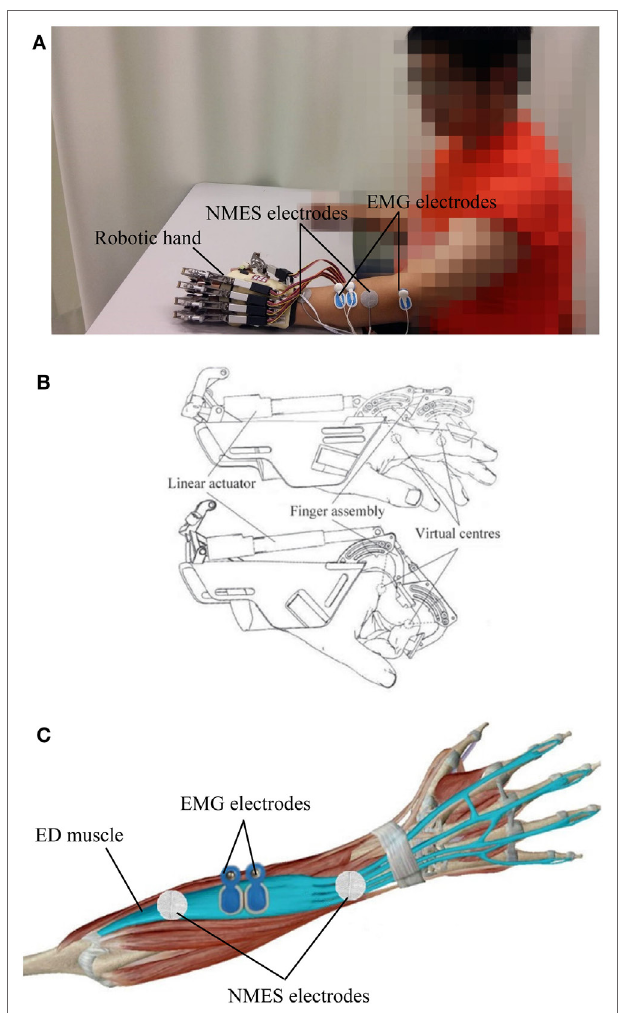
FiGUrE 1 | The electromyography (EMG)-driven neuromuscular electrical stimulation (NMES)-robotic hand system: (a) the wearable system consisting of a mechanical exoskeleton of the robotic hand, a pair of NMES electrodes attached to the extensor digitorum (ED) muscle, and EMG electrodes on the ED and abductor pollicis brevis muscles; (B) illustration of the mechanical structure of the robotic hand; (C) the EMG and NMES electrodes’ configuration on the ED